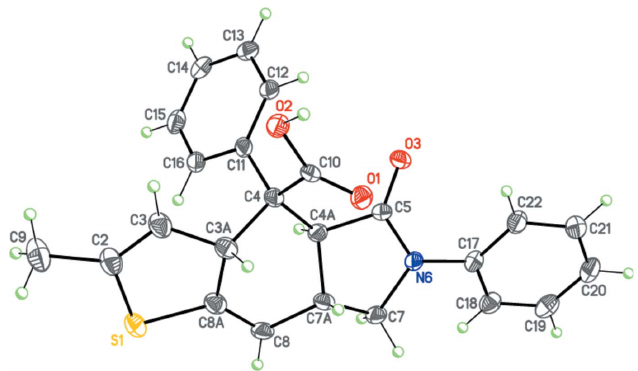
Figure 3 Molecular structure of I . Displacement ellipsoids are shown at the 50% probability level. H atoms are presented as small spheres of arbitrary radius.